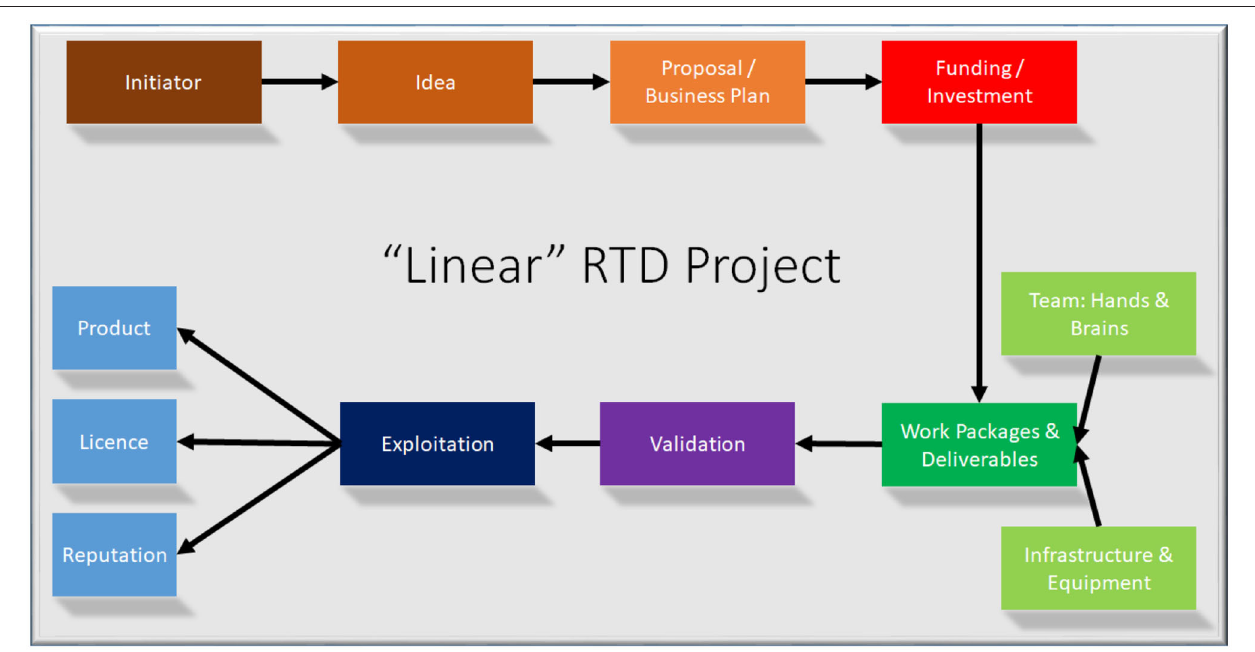
FIGURE 3 | Projects are traditionally organized in a linear fashion from starting with idea creation, advancement into a business plan, and attracting funding. Teams and their infrastructures are set up to execute work packages (WPs) that they (self-) validate. The results are then exploited through various avenues, e.g., by direct sales of a product, by licensing, or, in particular in academia, by publishing for building up reputation in the community.